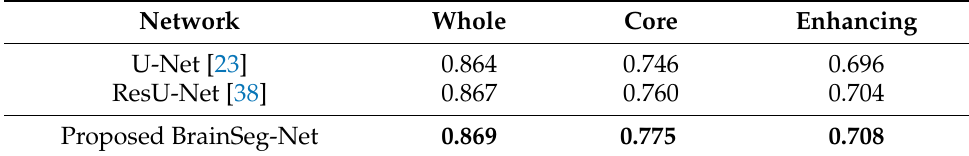
Table 5. Results comparison on the BraTS 2019 validation